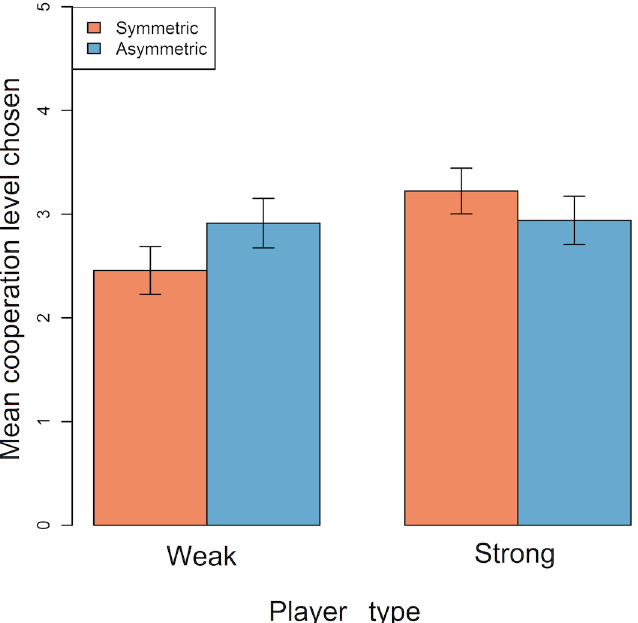
generated from raw data.